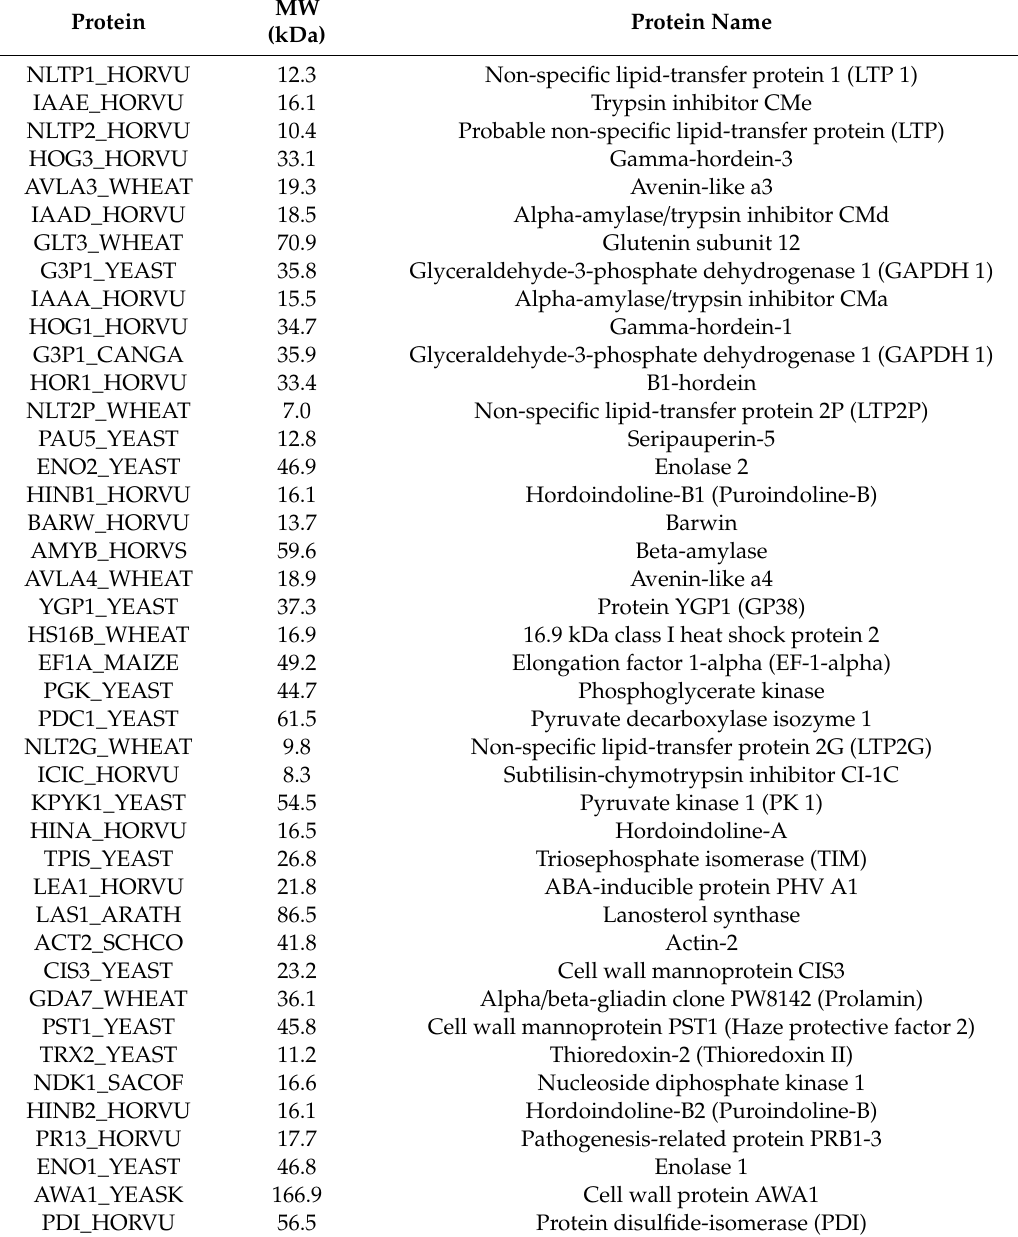
Table 2. Names of the 54 proteins used to develop the artificial neural network